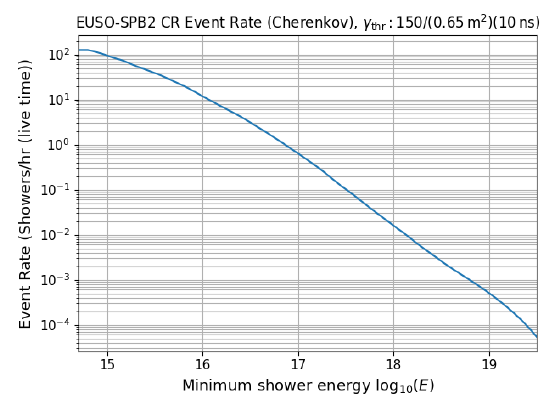
Figure 7: Cumulative event rate of above-the-limb cosmic rays as a function of primary energy for EUSO-SPB2’s CT, calculated using EASCherSim and trigger thresholds determined from field testing.